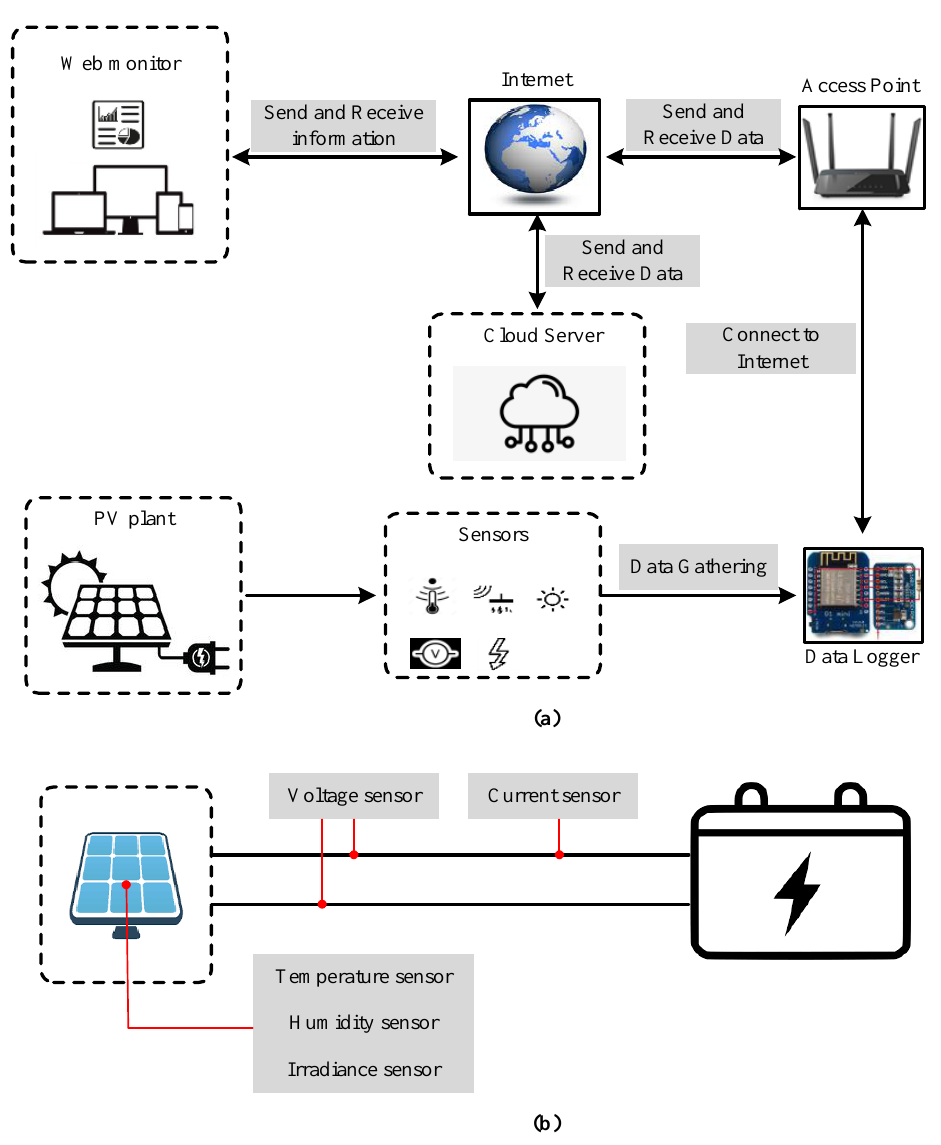
Figure 1. ( a ) An overview of Intelligent Monitoring System (ISM) architecture; ( b ) sensors distribution.